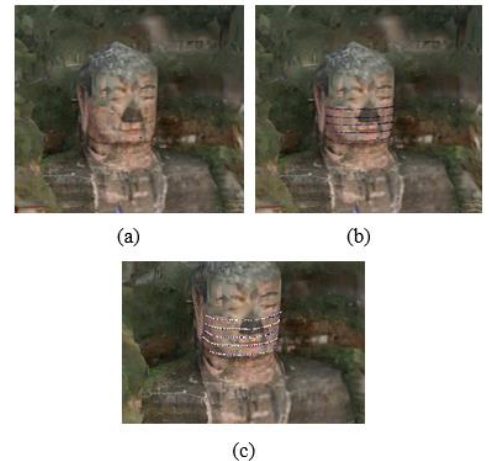
Figure 3 . The target (a), intersection points of contour lines with the surface (b), and generated line objects